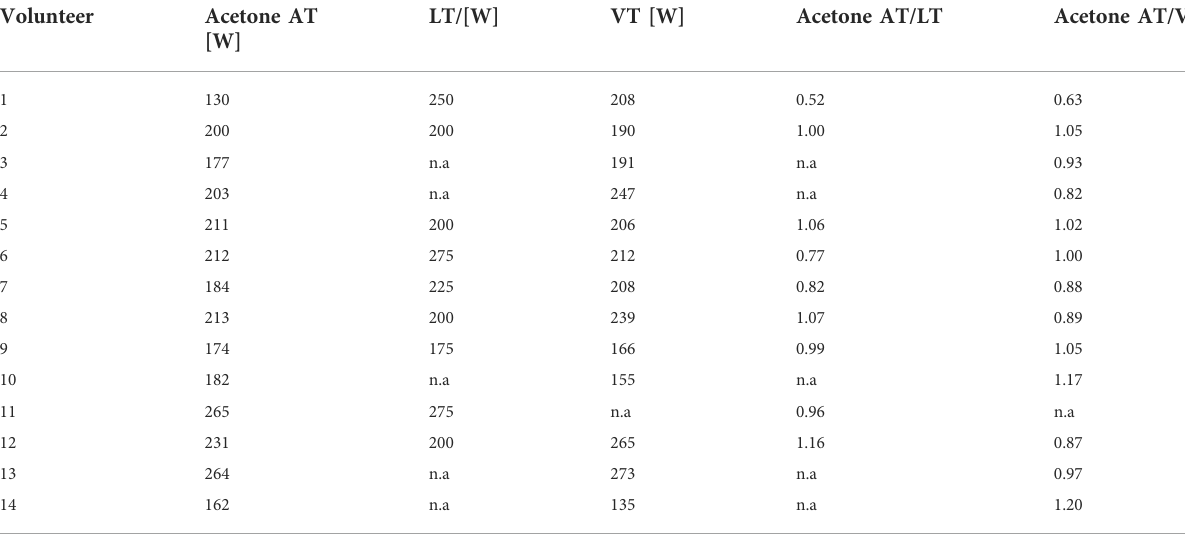
TABLE 4 Comparison between acetone AT with LT and